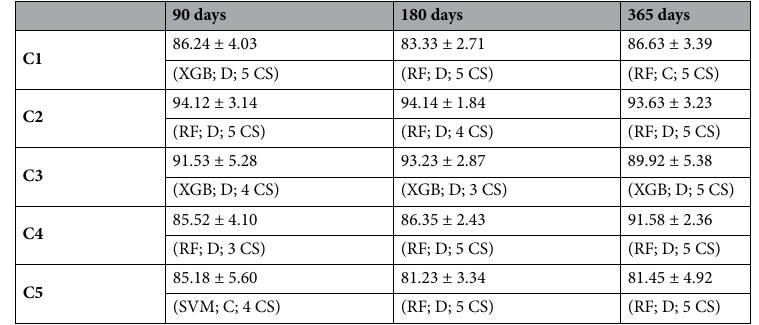
Table 8. Summary of the best AUC results obtained with the triclustering-based classification approach for each of the target endpoints according to each of the considered time windows. D stands for distance matrices as learning examples, while C stands for correlation matrices. C1, need for NIV; C2, need for an auxiliary communication device; C3, need for PEG; C4, need for a caregiver, and C5, need for a wheelchair.